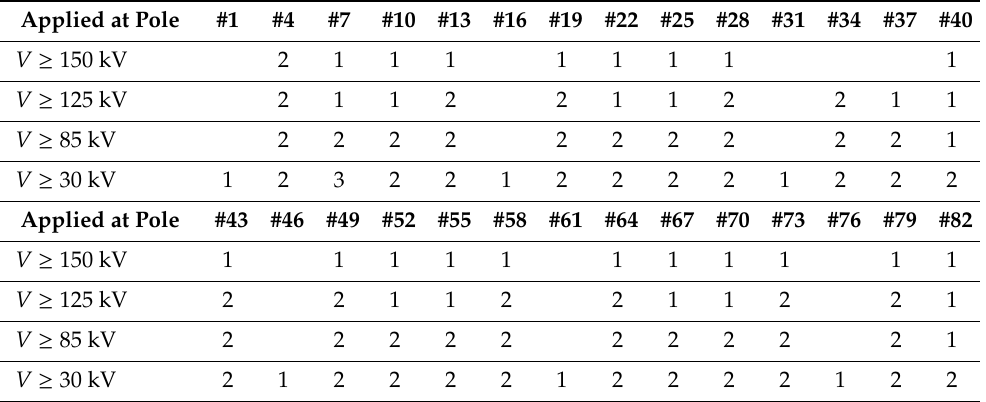
Table 10. Number of transformers with at least one phase reaching the critical overvoltage level. Case 3, dry poles, sub-configuration C3.1.